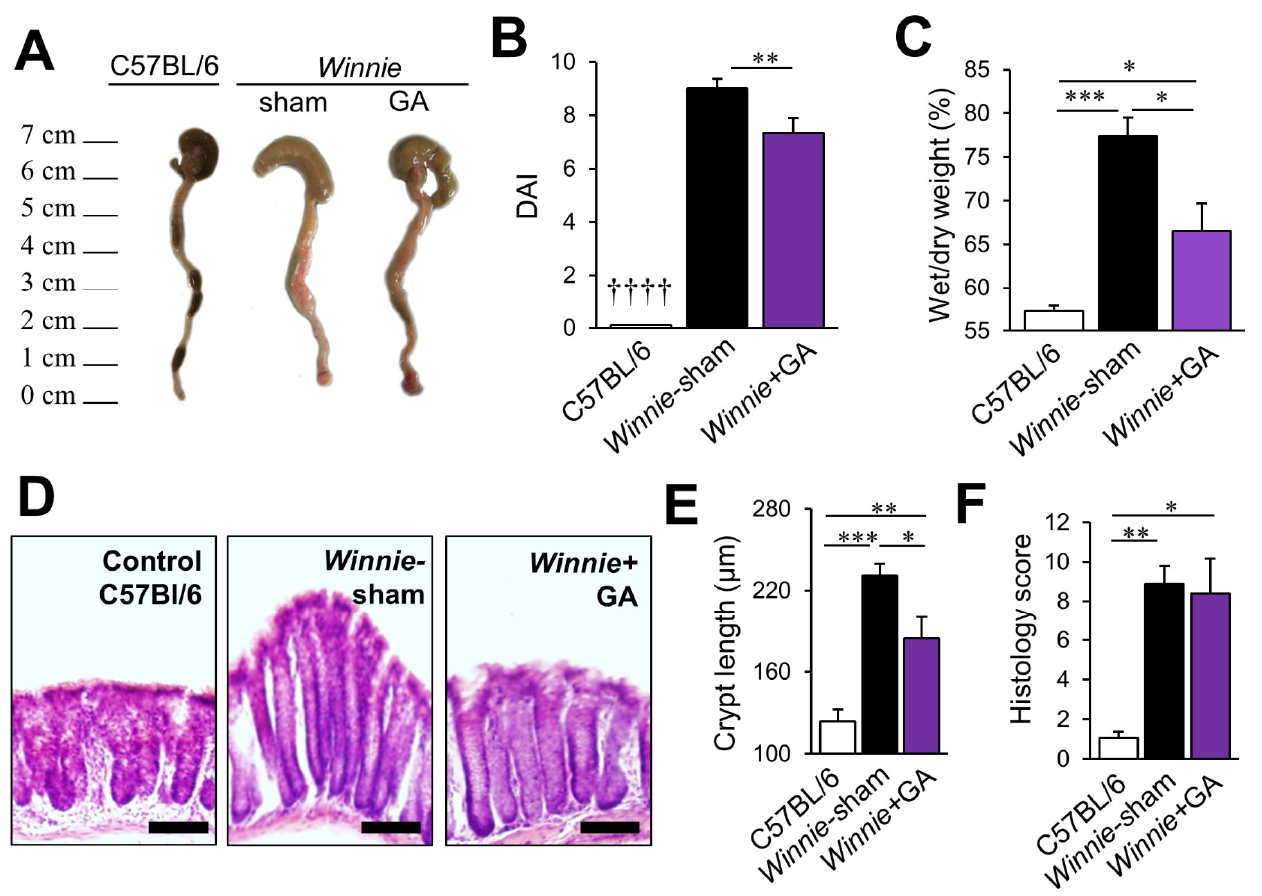
Figure 6. Effects of HMGB1 blocker, glycyrrhizic acid, on colon morphology and the disease activity in Winnie mice. ( A ) Representative photographs of the colons were obtained from C57BL/6 mice, sham-treated Winnie mice and Winnie mice treated with glycyrrhizic acid (GA). ( B ) Disease Activity Index (DAI) of colitis consisting of rectal bleeding, prolapse, colon morphology, diarrhoea and weight loss in C57BL/6 mice, Winnie mice treated with vehicle sham and Winnie mice treated with glycyrrhizic acid (GA). ** p < 0.01 between Winnie -sham and Winnie + GA, †††† p < 0.0001 between C57BL/6 and both Winnie -sham and Winnie + GA; n = 6 animals/group. ( C ) Faecal water content was determined by comparing the wet weight to the dry weight of faecal pellets from C57BL/6 mice, Winnie mice treated with vehicle sham and Winnie mice treated with glycyrrhizic acid. * p < 0.05, *** p < 0.001; n = 6 animals/group. ( D ) Representative images of haematoxylin and eosin staining (top row) of the cross-sections of the colons from C57BL/6 mice, Winnie mice treated with vehicle (sham) and Winnie mice treated with glycyrrhizic acid. Scale bars = 100 µ m. ( E ) Quantification of the length ( µ m) of mucosal crypts and in the colon. * p < 0.05, ** p < 0.01, *** p < 0.001; C57BL/6 mice: n = 5; Winnie Sham and GA: n = 4 animals/group. ( F ) Quantification of histological grading of colitis in the colon. * p < 0.05, ** p < 0.01; n = 5 animals/group.